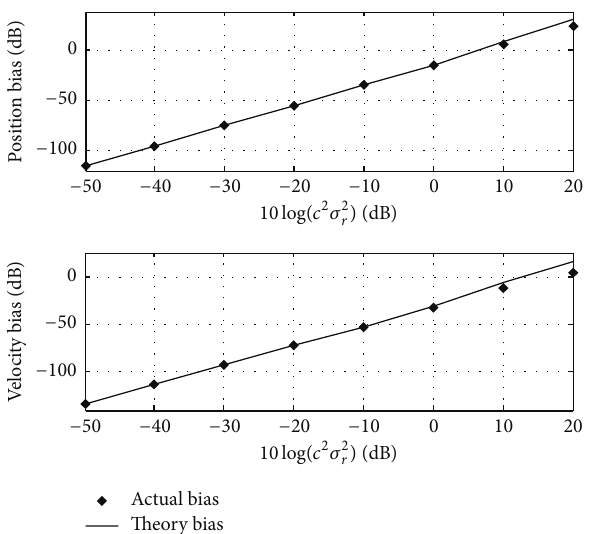
Figure 3: Comparison between theoretical and actual bias of estimation of source position and velocity by MLE for near-field source.